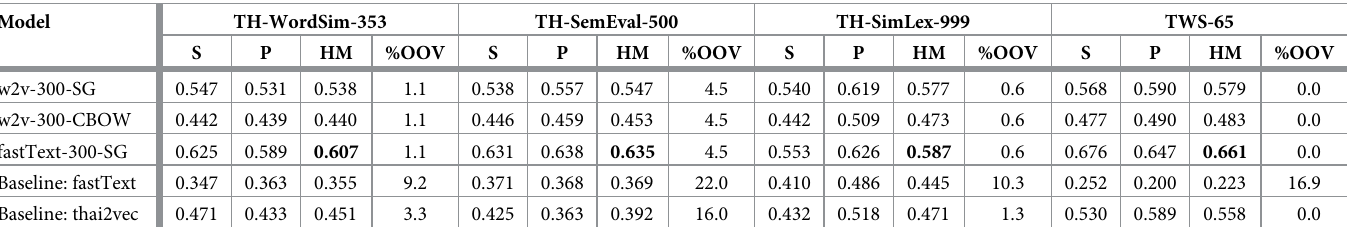
Table 3. Evaluation metrics Spearman ρ (S), Pearson ρ (P) and Harmonic Mean (HM) of the two–for the self-trained models and the pretrained baselines, with deep- cut applied to the datasets terms . Further, the ratio of OOV words (%OOV).